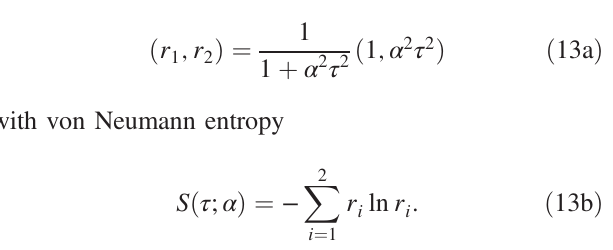
FIG. 12. Bipartite MPO entanglement across the center of the system in the SLH, up to width W ¼ 6 . The system length is fixed to L ¼ 10 for width W ¼ 2 , 3, 4, 5 and to L ¼ 12 for W ¼ 6 . For W ≤ 4 , the entanglement entropy in the center of the system is well converged by retaining D (cid:3) ¼ 500 bond multiplets. For W ¼ 5 and 6, we show data with D (cid:3) ð D Þ ¼ 300 (1000) and 550 (2000) (color matched lines) as well as extrapolated data (symbols) based on a quadratic polynomial extrapolation in 1 =D (cid:3) → 0 that includes additional data between D (cid:3) ¼ 300 and D (cid:3) ¼ 550 . The inset presents the entropy per leg ( S E =W ) on a log-log scale, where the power-law increase for β ≪ 1 again clearly follows the large-temperature fit in Eq. (13) with approximate exponent γ ≃ 2 , using α ¼ 0 . 05 . The dashed line shows S ∼ β as a guide to E the eye for